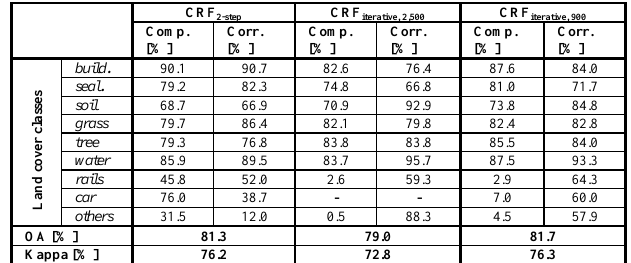
Table 1. Overall accuracy [%], kappa index [%],